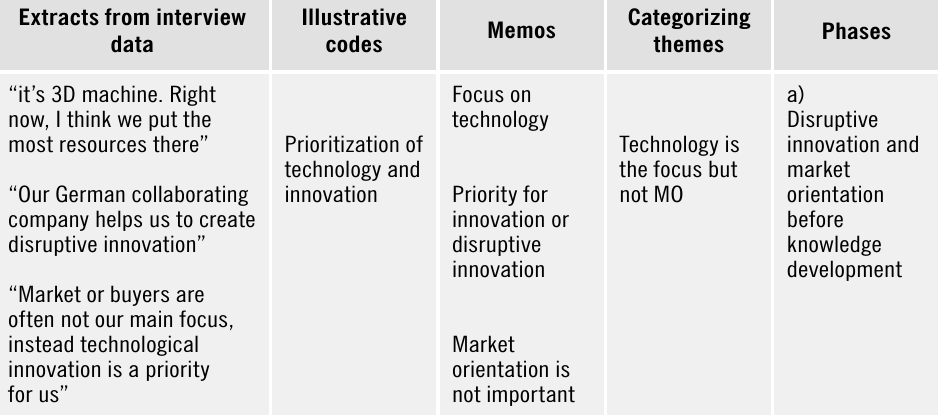
Table 2. The process of illustrative coding and developing themes Extracts from